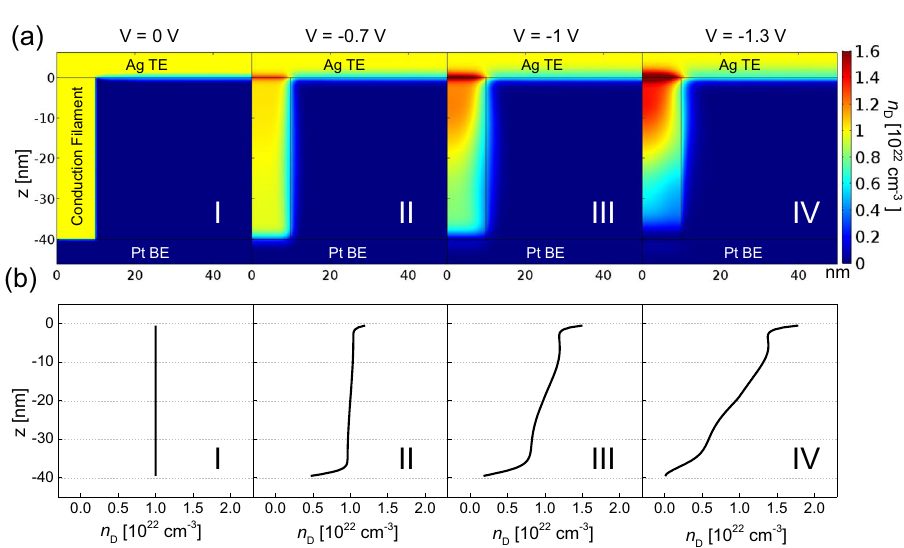
Figure 5. COMSOL Multiphysics simulation results for the RESET process. ( a ) Calculated 2D images of n D and ( b ) 1D profiles for states I (0 V), II ( − 0.7 V), III ( − 1 V), and IV ( − 1.3